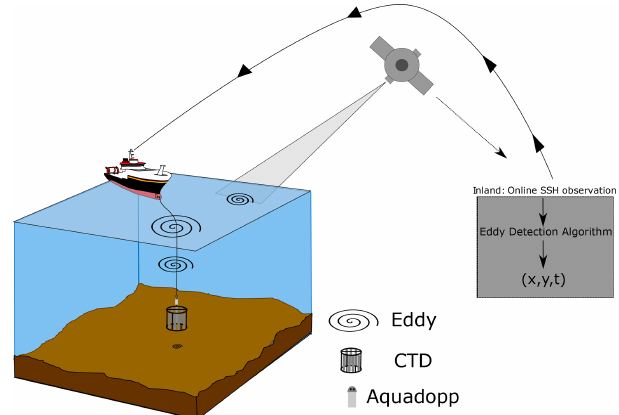
Figure 3. The concept of online communication between the re- search vessel in the NETP and the shore-based eddy detection group using online satellite data for determining the positions for hy- drographic measurements. Figure is not to scale. Eddy, CTD, and Aquadopp are